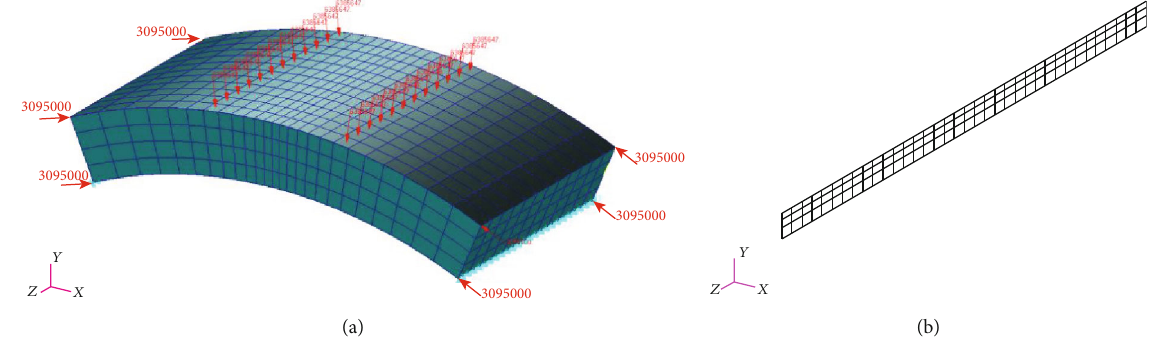
Figure 8: Meshes for the cracked tunnel lining segment: (a) the uncracked global structure is molded with fi nite elements (10-noded tetrahedron elements); (b) the initial crack surface is molded independently with boundary elements (8-noded quadrilateral elements).